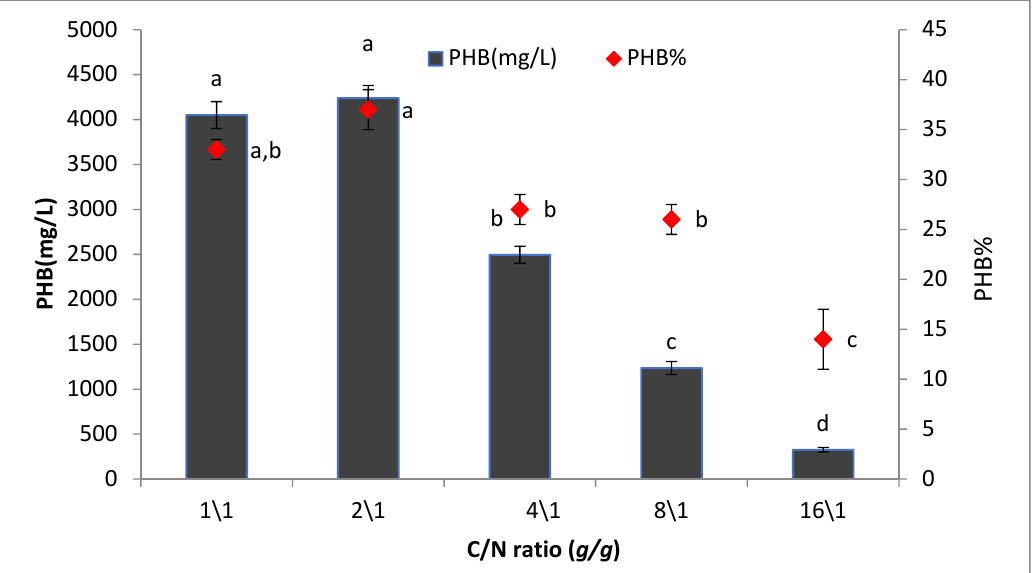
Figure 11. Effect of C/N ratio on the production of polyhydroxybutyrate (PHB) by Bacillus wiedmannii strain. The ANOVA